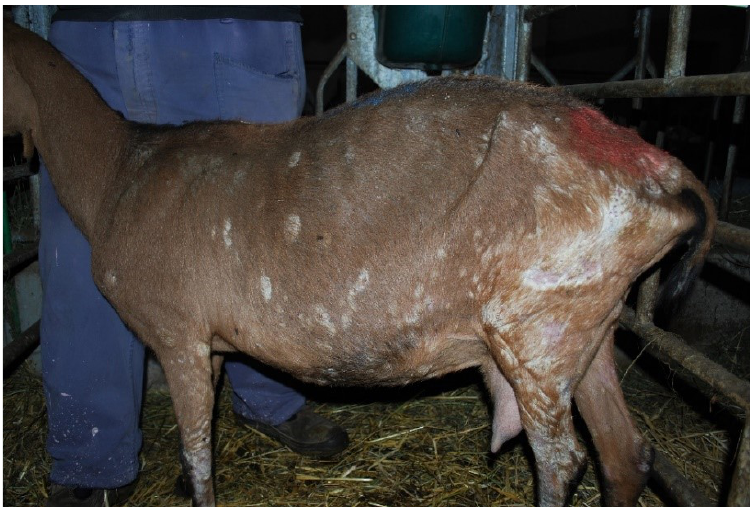
Figure 2. Extensive exfoliative and crusty dermatitis in a goat infected by C. bovis and T. verrucosum. None of the Saanen goats exhibited symptoms.